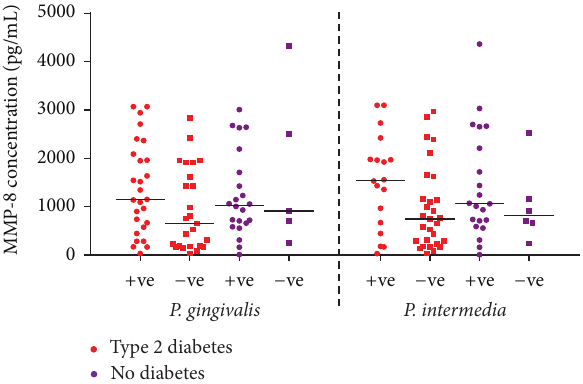
Figure 3: Distribution of salivary MMP-8 concentrations (pg/mL) according to the prevalence of P. gingivalis and P. intermedia in subjects with and without type 2 diabetes regardless of the periodontal status ( 𝑛 = 80 ).